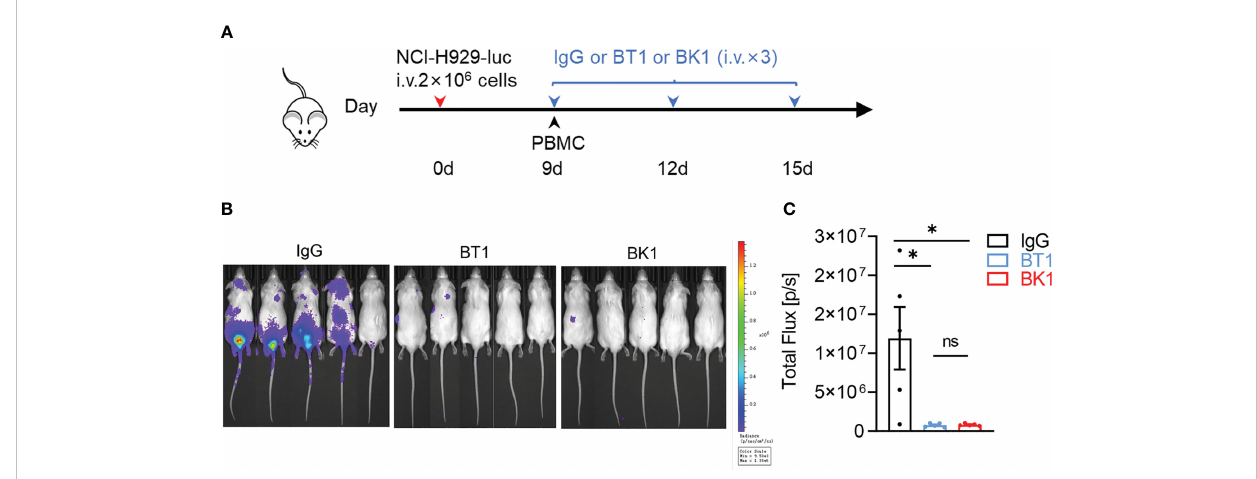
FIGURE 5 BT1 and BK1 show comparable antitumor effects in a PBMC-reconstituted xenogeneic tumor model. (A) Experimental protocol for the tumor model used in (B, C) : NSG mice (n = 5/group) were injected intravenously (i.v.) with NCI-H929-luc tumor cells (2 × 10 6 ) on day 0 followed by intravenous injection of PBMCs (1 × 10 7 ) on day 9. Tumor-bearing mice were injected intravenously (i.v.) with IgG, BT1 or BK1 (50 m g/mouse) every 3 days for a total of 3 doses beginning on day 9. (B) In vivo bioluminescence imaging of mice 18 days after the tumor challenge described in (A) . (C) Quanti fi cation of luminescence in IgG-treated, BT1-treated or BK1-treated mice on day 18. Each symbol (C) represents an individual mouse. (B, C) : Data are representative of at least three independent experiments. Data were analyzed by Student ’ s t test. ns:P>0.05; *P <